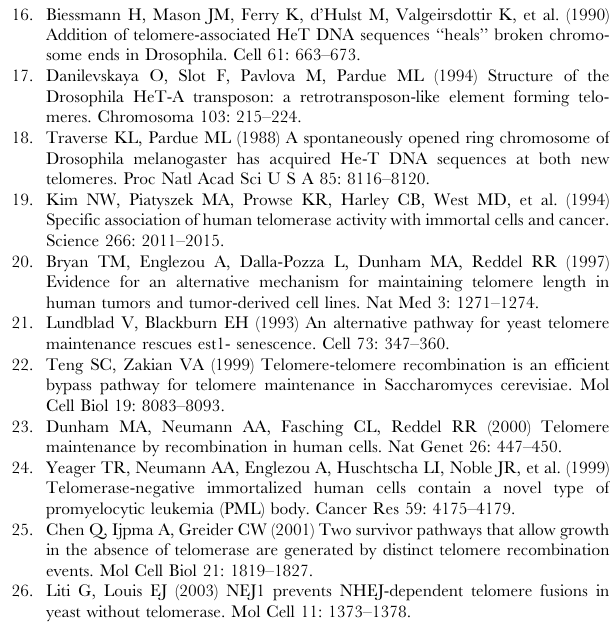
Figure S3 The liquid viability assay of est2 D and est2 D tor1 D mutants. Experimental procedure the same as Figure